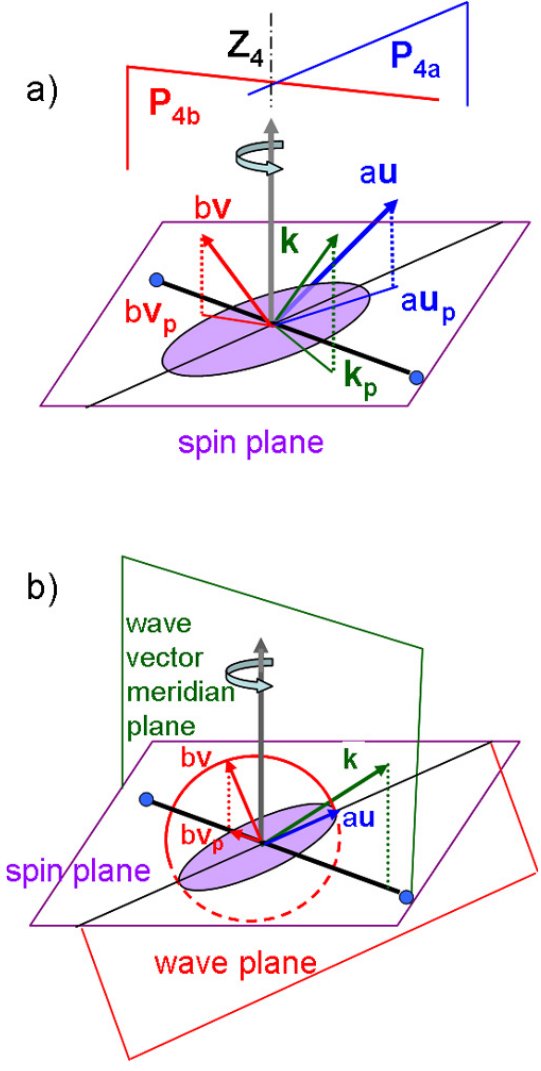
Fig. 3. Case of elliptic polarization. (a) Linear components a u and b v of an electric field elliptically polarized. Vectors u and v of the wave plane and its normal k are shown in [ S C4 ] coordinate system. Meridian planes P 4 a and P 4 b contain Z 4 axis and, respectively, u and v vectors. Projections u p , v p and k p of u , v and k onto C4 spin plane are shown, as well as the electric field ellipse projected onto the same plane (purple area). (b) Specific case of circular polariza- tion where principal axis positions have been chosen such that u vector was in the spin plane. Projections u p ( u p = u ) and v p are at a right angle to each other. The meridian plane (drawn in green) formed by the spin axis and v p contains the wave vector k